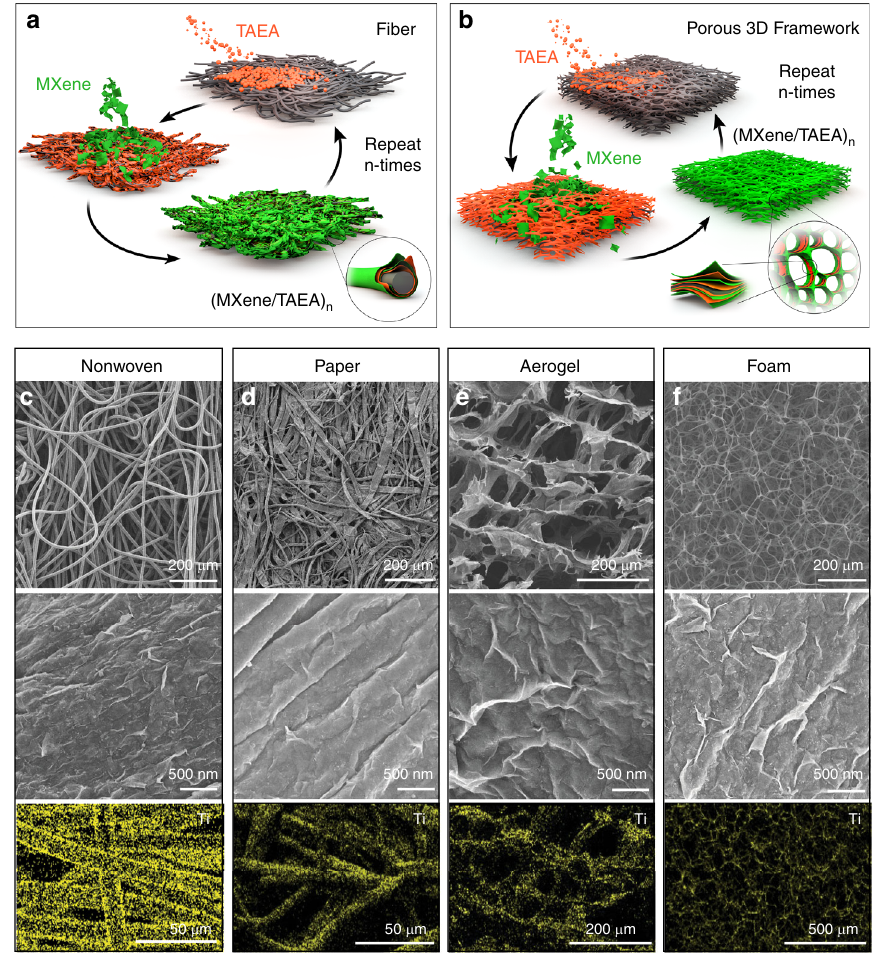
Fig. 3 (MXene/TAEA) n multilayers on porous structures. Schematic illustration of the LbL self-assembly of (MXene/TAEA) n multilayer fi lms onto a fi